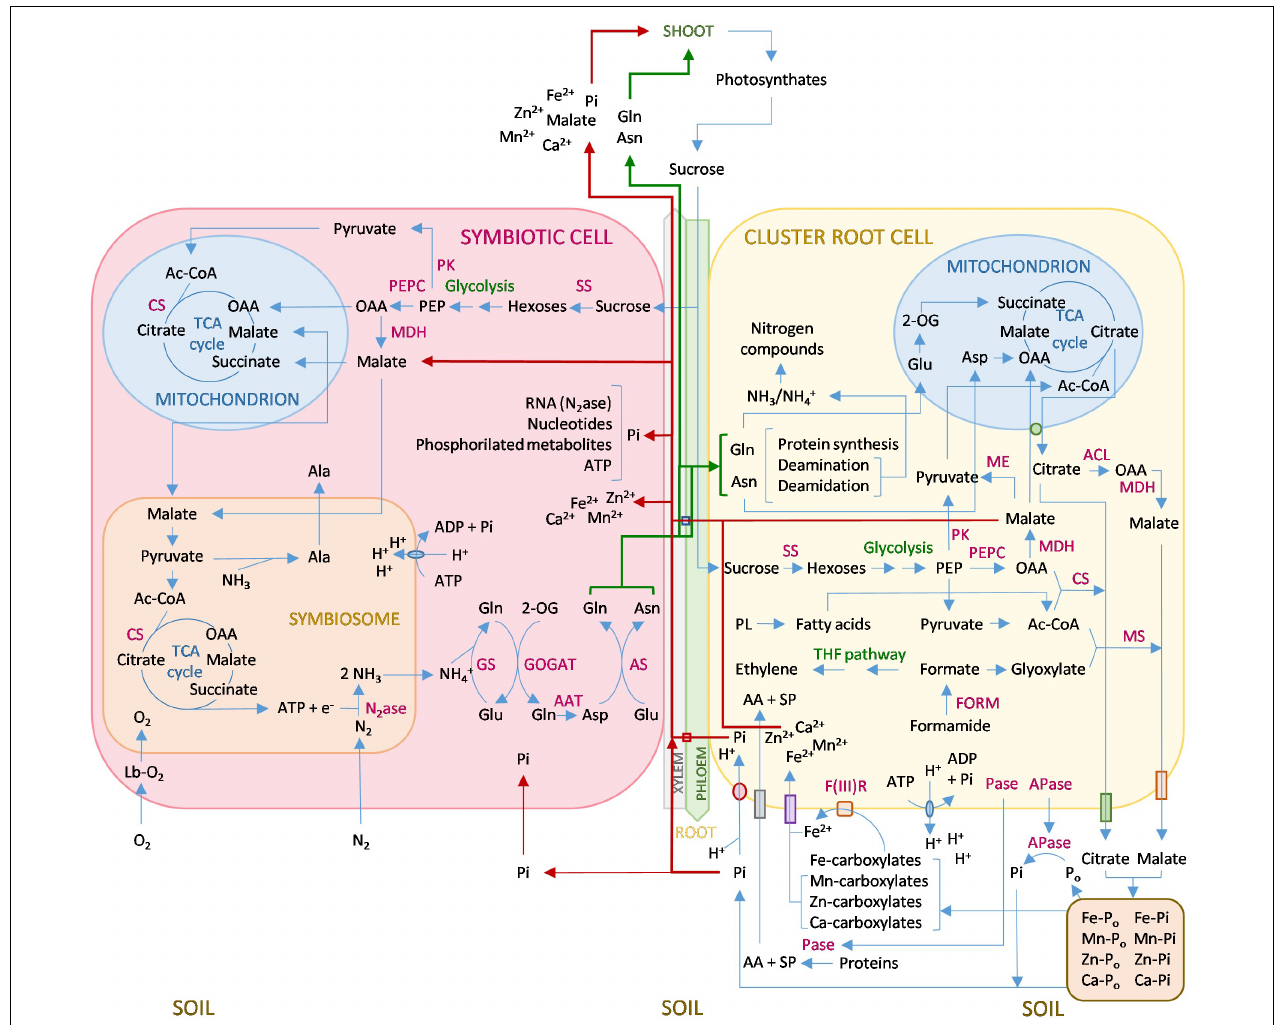
FIGURE 1 | Simplified metabolism of Lupinus albus nodules and cluster roots under P and N deficiencies. In summary, sucrose is transported from the shoot via the phloem, and glycolysis is activated in both the symbiotic cells and the cluster root cells to increase the amount of malate and OAA, which are integrated into the TCA cycles running in both mitochondria and symbiosomes. In cluster root cells, malate is also secreted to the soil through a specific transporter and may be transported via xylem to fuel the symbiotic cell and to the aerial organs. In nodules, there is an upregulation of MDH, while in cluster roots PEPC is the principal upregulated glycolysis enzyme. In cluster roots, formate is produced by an upregulation of FORM, which leads to activation of the THF pathway, which produces ethylene. Formate is also used to synthesize malate by MS. Phospholipid degradation occurs to provide Pi and Ac-CoA, which in turn combines with OAA to yield citrate catalyzed by CS, or with glyoxylate to form malate by MS. Malate and citrate keep a balance mediated by the TCA cycles and several enzymes, inducing ACL, MDH, MS, and CS. Citrate is mainly produced in the mitochondrion and secreted to the soil through permeable channels. This process is associated with a membrane H + ATPase, and protons are also released, leading to soil acidification. Additionally, APases are secreted to the soil. The combined action of carboxylates, the acidification of the medium, and the secreted APases is capable of mobilizing unavailable P in the soil and generate Pi, which is co-transported with protons into the root cell. Pi can reach the symbiotic cell by absorption through the nodule surface or, mainly, be transported via xylem. Pi is needed in the first place for the synthesis of nitrogenase RNA, which has a very high turnover. Carboxylates also chelate cations that bind to P, mainly Fe 3 + , which is reduced to Fe 2 + by a plasma membrane Fe(III)R and enters the cell via a Fe 2 + transporter. Other micronutrients are also mobilized and enter the root cell together with Fe 2 + . The nutrients are transported to the symbiotic cell and the rest of the plant via xylem. In the nodule, O 2 permeates the cortex to bind leghemoglobin, controlling the right levels for nitrogenase functioning in the symbiosome, which produces NH 3 that exits the symbiosome and is protonated in the symbiotic cell and then converted to Asn and Gln in a process catalized by several enzymes GS, GOGAT, AAT, and AS. Asn and Gln are transported to the plant, including the cluster root cells, where, among other functions, they are converted to Asp that enters the mitochondrion to fuel the TCA cycle through OAA, and to Glu that is converted to 2-OG and also enters the TCA cycle. Lupin cluster roots are also capable of secreting proteases that degrade organic N to amino acids and small di- and tri-peptides that enter the root cell through membrane transporters. Red arrows indicate the transport of Pi, malate, and nutrients to the symbiotic cell and the shoots. Green arrows indicate transport of Asn and Gln. Abbreviations: 2-OG, 2-oxoglutarate; AA, amino acids; AAT, aspartate aminotransferase; ACL, ATP citrate lyase; Ac-CoA, acetyl CoA; APase, acid phosphatase; AS, asparagine synthetase; CS, citrate synthase; F(III)R, F 3 + reductase; FORM, formamidase; GOGAT, Glu synthase; GS, Gln synthetase; Lb, leghemoglobin; MDH, malate dehydrogenase; MS, malate synthase; N 2 ase, nitrogenase; OAA, oxaloacetate; Pase, protease; PEP, phosphoenolpyruvate; PEPC, phosphoenolpyruvate carboxylase; PL, phospholipids; PLA1, phospholipase A; PK, PEP kinase; SP, small peptides; SS, sucrose synthase; TCA, tricarboxylic acid; THF pathway, tetrahydrofolate pathway.